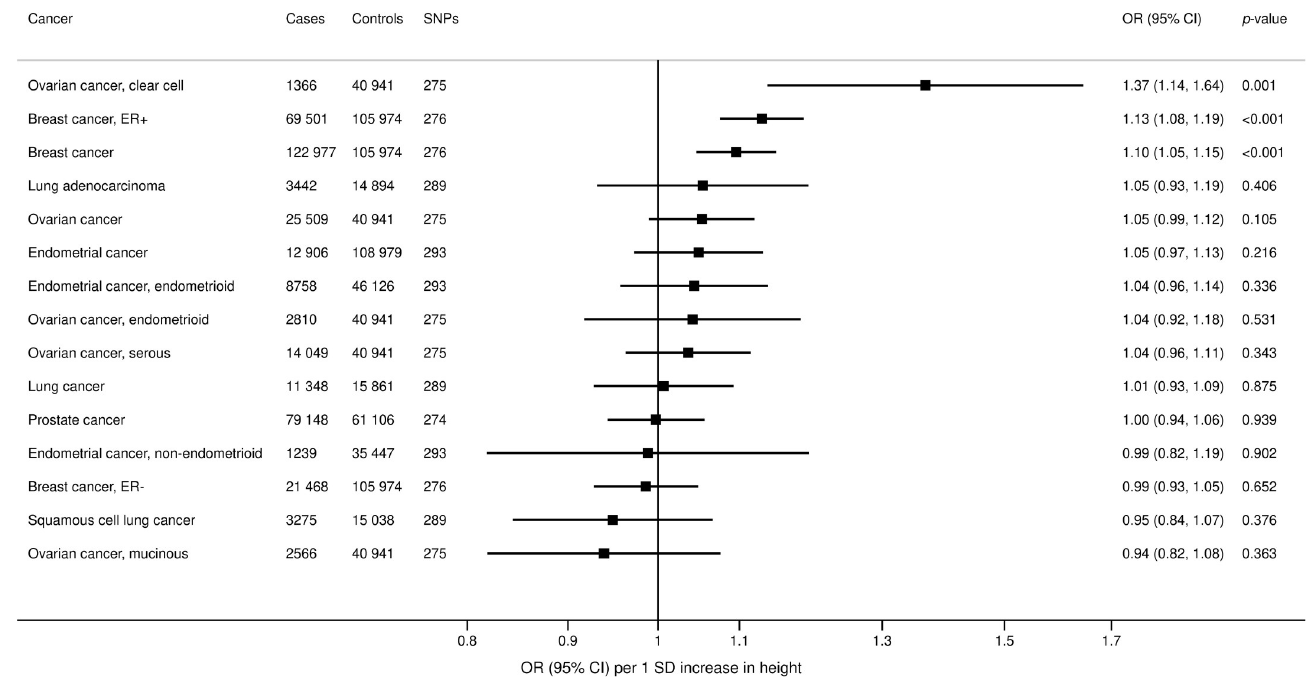
Fig 6. Associations of genetically predicted height with site-specific cancers in large international consortia. ORs are expressed per 1 standard deviation (6.5 cm) increase in height. Results are obtained from the random-effects inverse-variance weighted method. CI, confidence interval; ER − , estrogen receptor negative; ER+, estrogen receptor positive; OR, odds ratio; SNP, single nucleotide